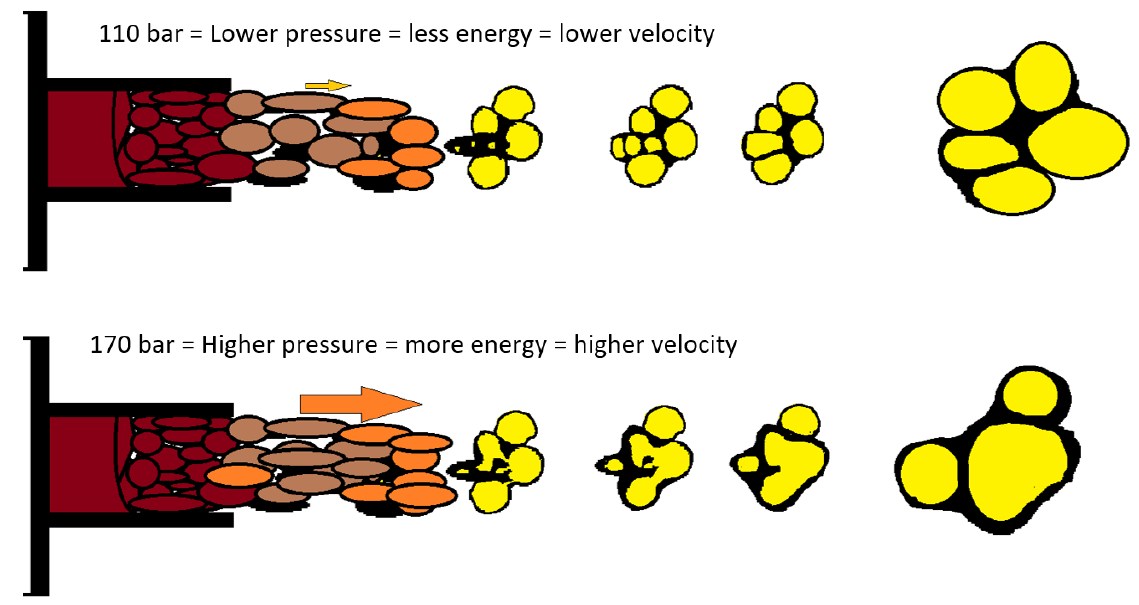
Figure 6. Scheme of injection and pore merging.